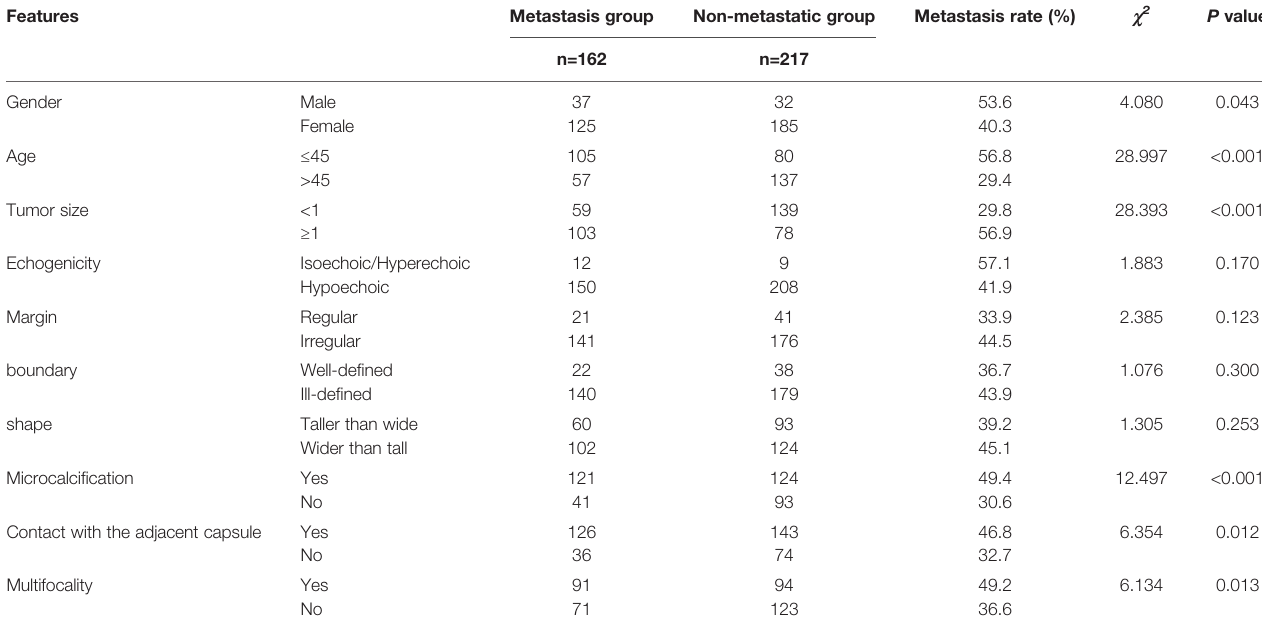
TABLE 1 | Comparison of characteristics of PTCs between lymph node metastasis group and non-metastatic group. Features